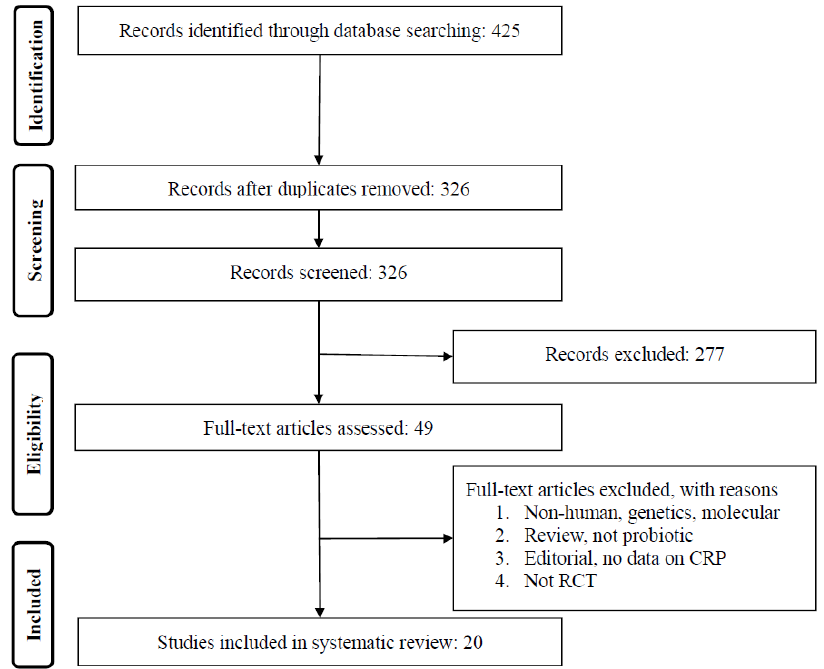
Figure 1. Preferred Reporting Items for Systematic Reviews and Meta ‐ Analyses (PRISMA) flow chart for the selection of studies. CRP, C ‐ reactive protein; RCT, randomized control trial.